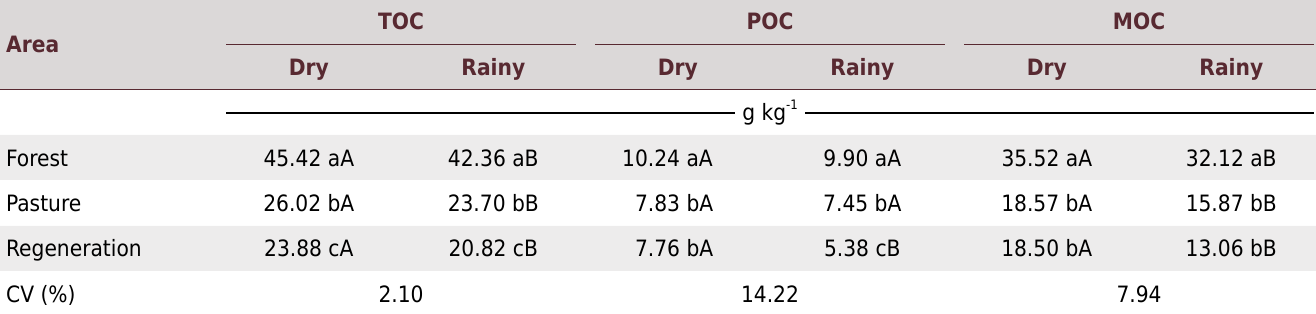
Means followed by the same uppercase letter in a row and the same lowercase letter in a column do not differ statistically (Bonferroni t test,